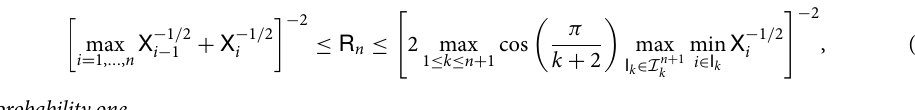
Figure 5. Histograms of 10, 000 R n values in Example 5 for n The theory predicts that as n